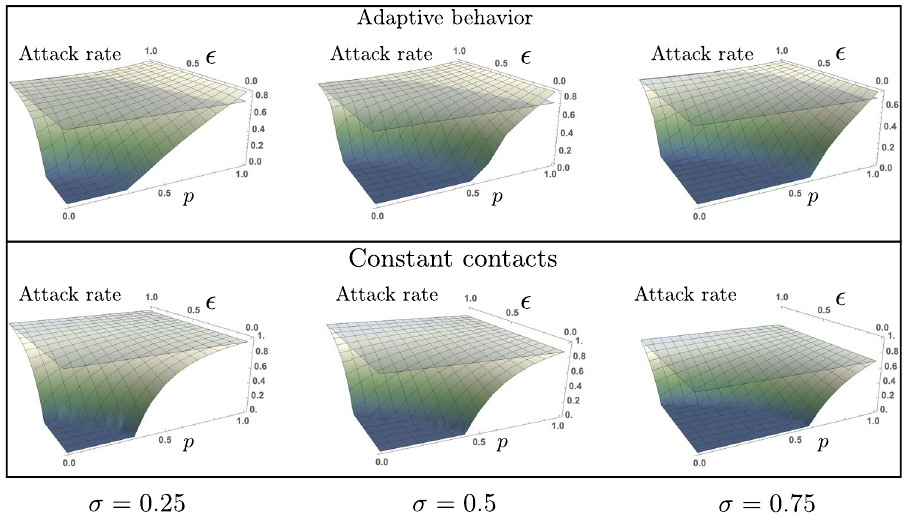
Figure 5. The trade-off between RE’s risk-reduction and the proportion of RT individuals depends on the proportion of asymptomatic cases. Attack rates obtained with the constant contacts model, and with the adaptive behavior model, for the scenarios where 25%, 50%, or 75% of infections are asymptomatic. The ( p , ε) regions where the attack rate is increased compared to the baseline scenario ( p = 0, ε = 1 ) is modulated by the presence of asymptomatic cases. The set of parameters used are those in Table 1.